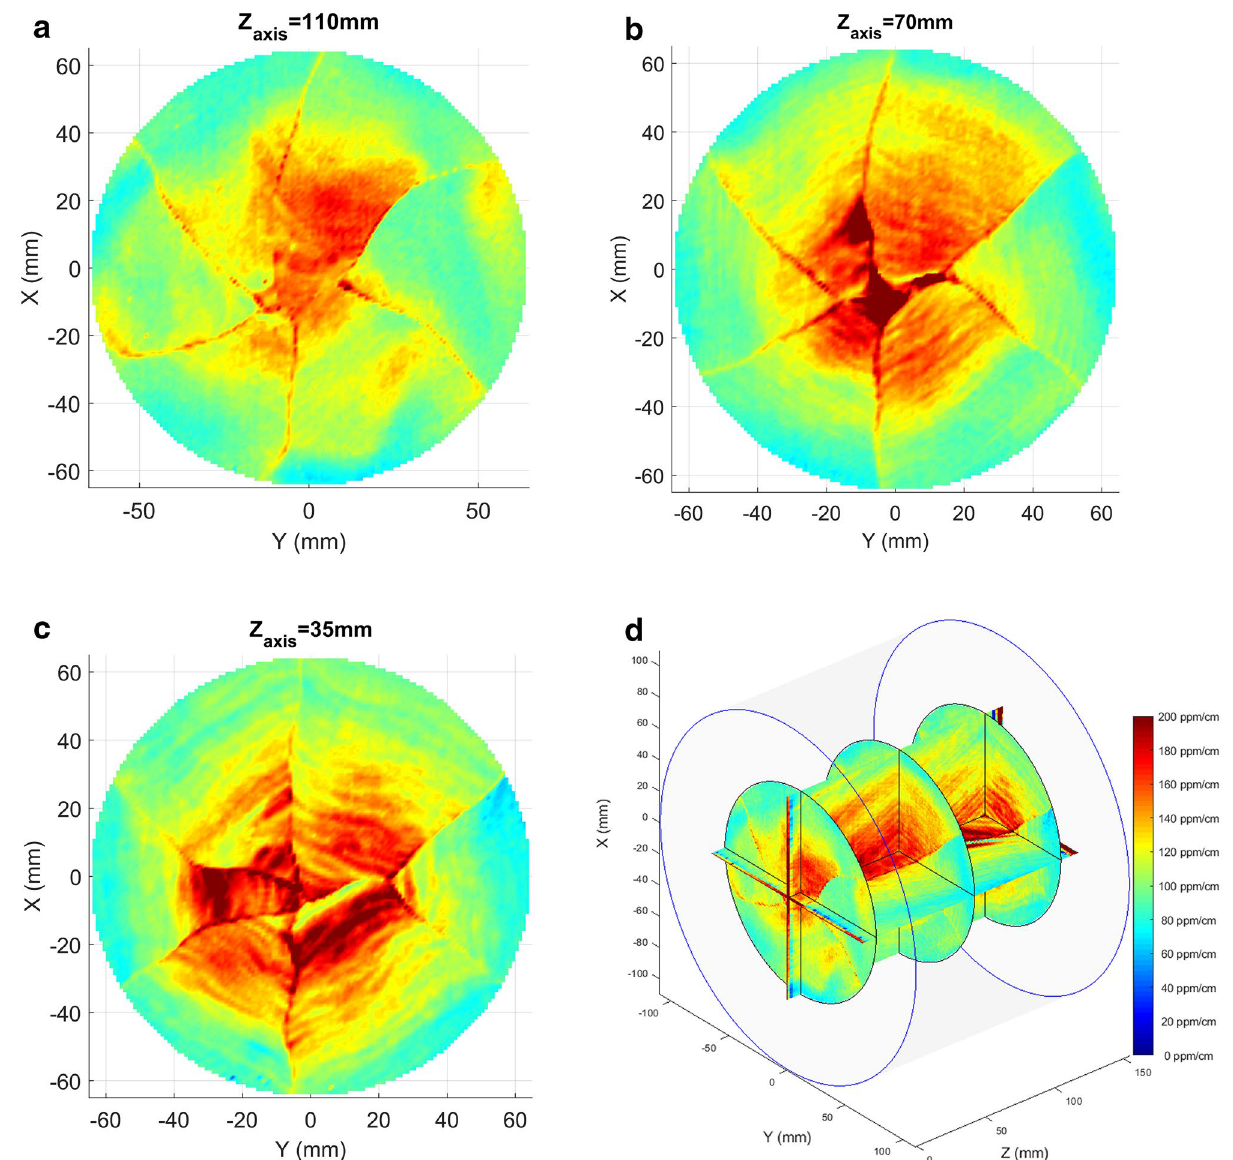
Figure 3. The circular absorption maps of the sapphire substrate at about 1 cm from the first surface (a) , in the middle of the sample (b) , and at about 1 cm from the second surface (c) . In the bottom-right figure (d) the 3D composition of the three circular maps together with the two rectangular one. A very good agreement in the spatial features of absorption can be observed.